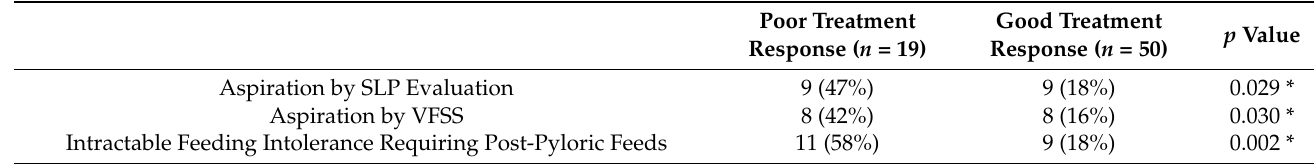
Table 5. Individual Aspiration Variables for 2-Ventricle